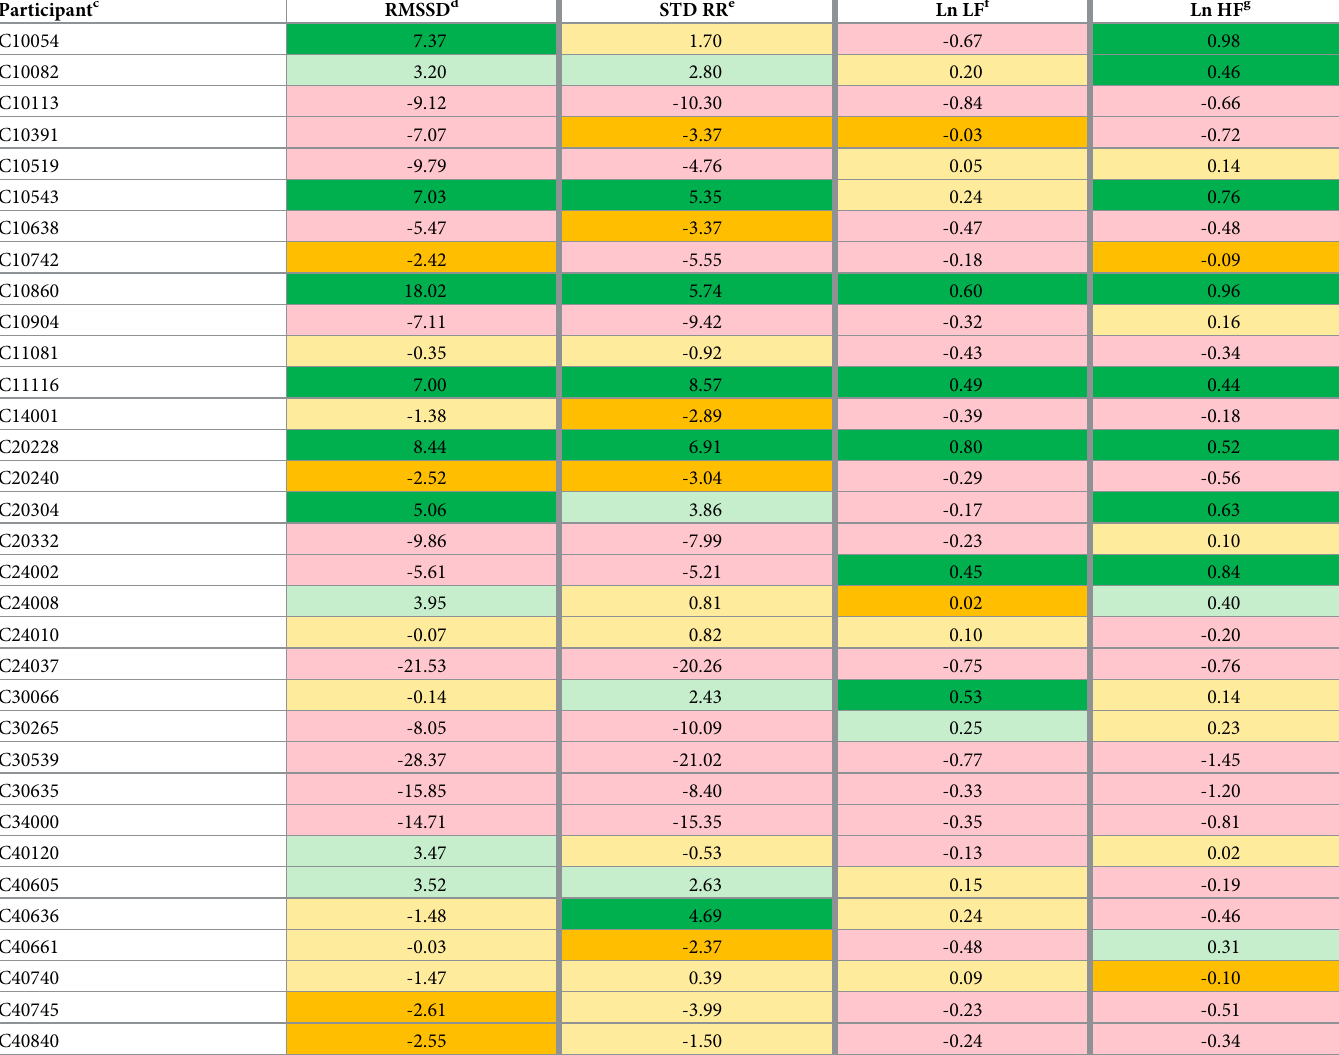
Table 6. Heat-map comparing within-participant differences in mean HRV for non-stressor intervals vs. stressor intervals, excluding intervals during physical activity bouts a,b . Participant